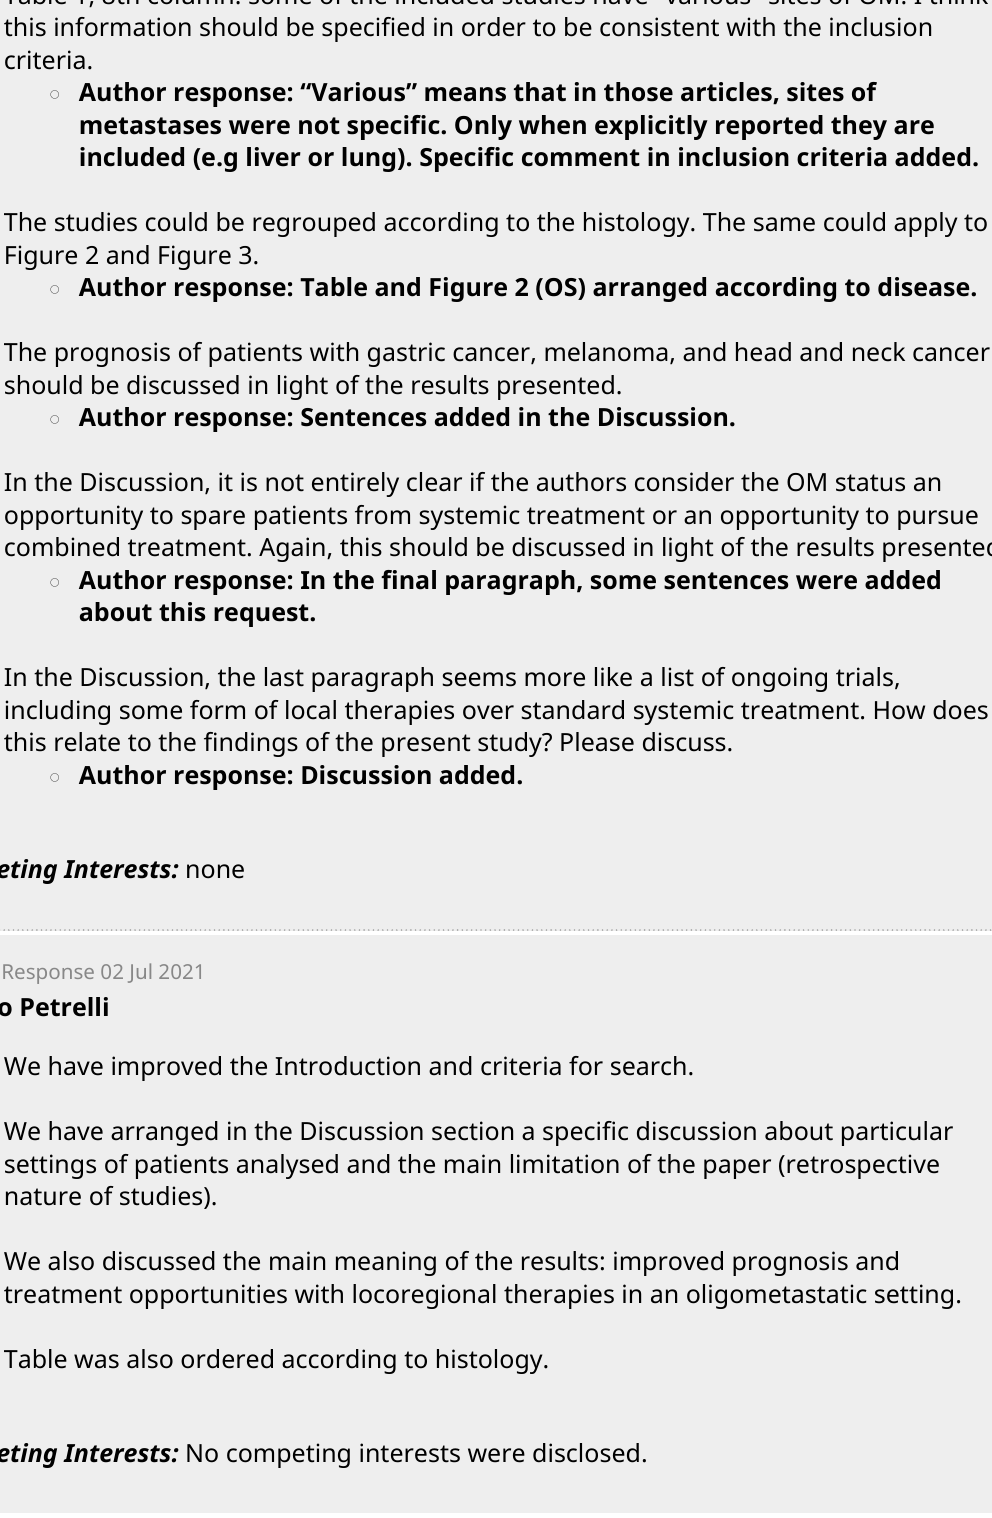
Table 1, 8th column: some of the included studies have "various" sites of OM. I think this information should be specified in order to be consistent with the inclusion